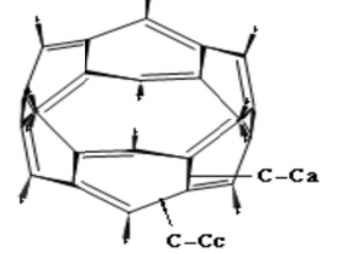
Fig. 8: Stru ndicating th C-C axial